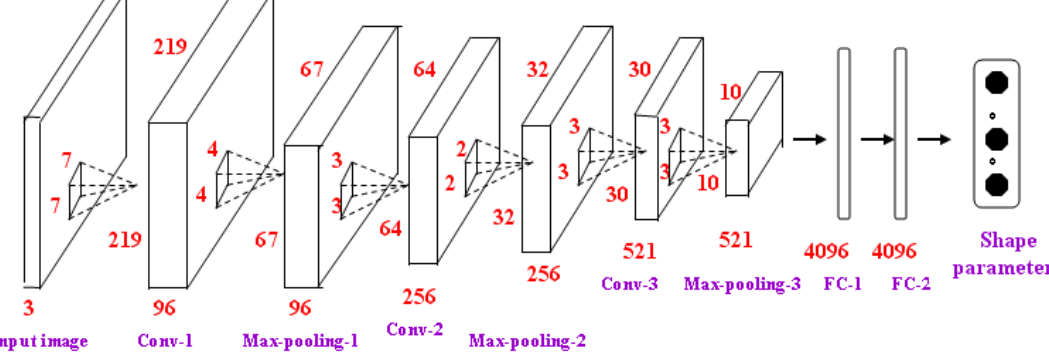
Figure 7. The shape parameters regression based on the LBP images.